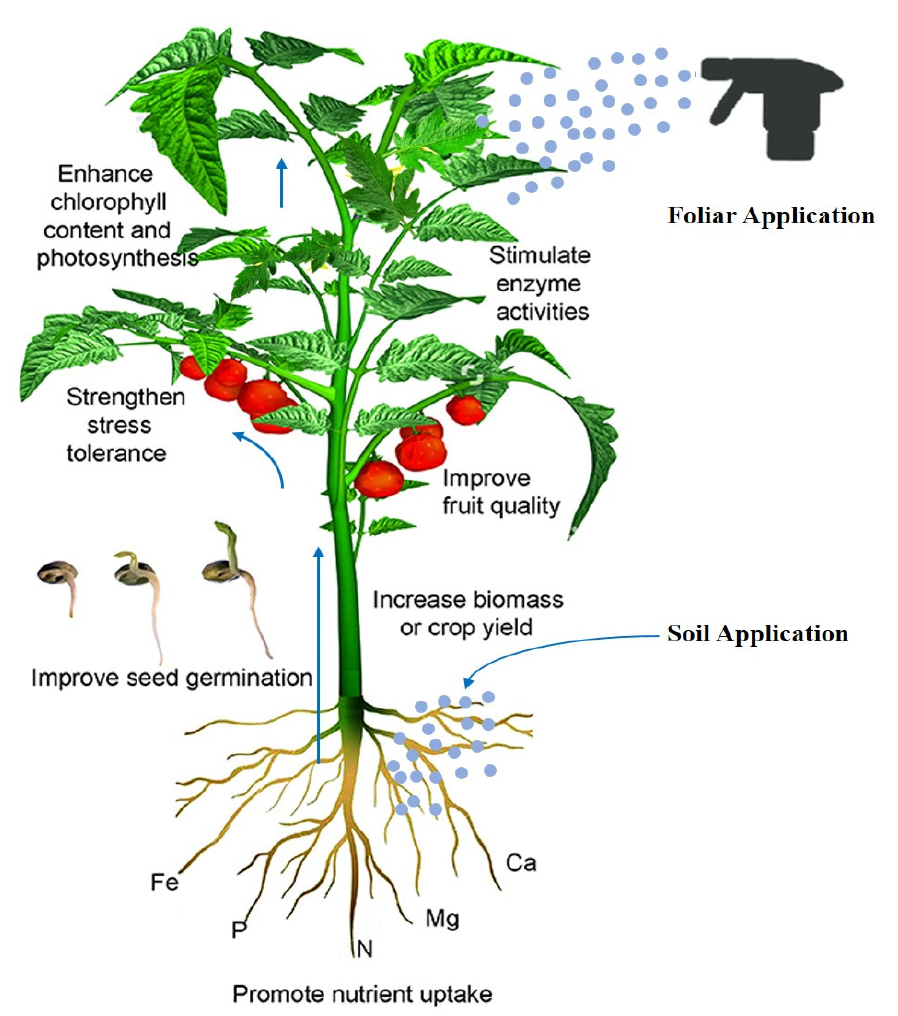
Figure 1. Method of foliar fertilization.